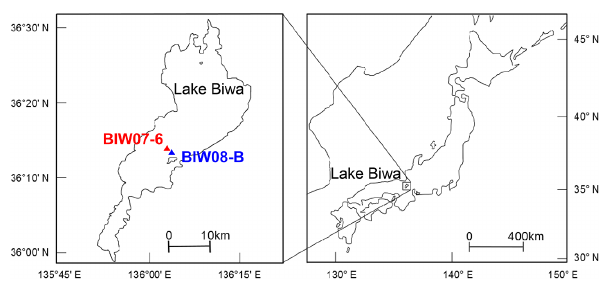
Figure 1. Map showing the study